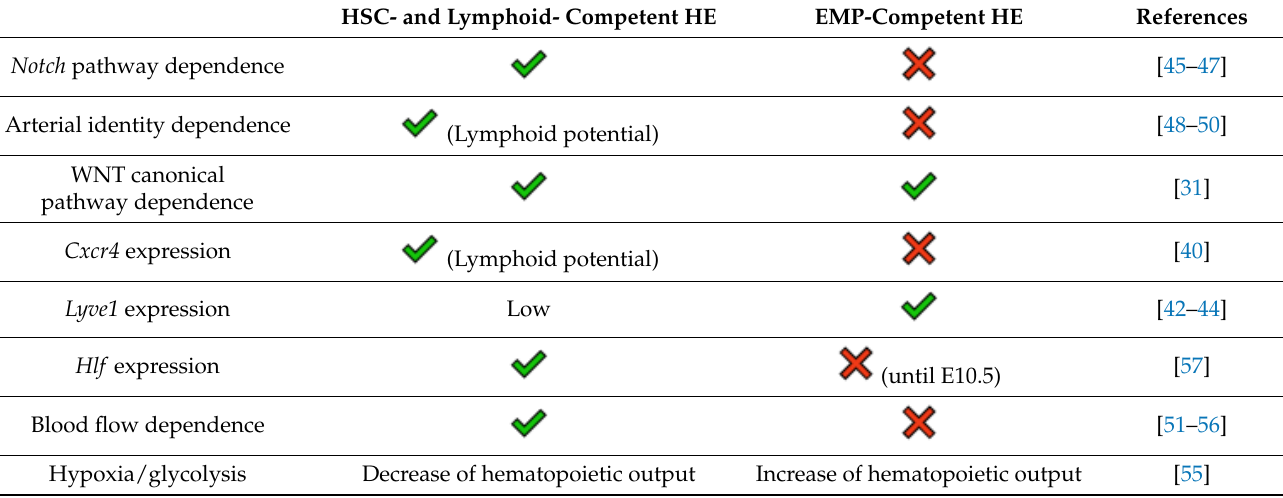
Table 1. Characteristics of EMP-competent and HSC or lymphoid- competent hemogenic endothe- lium. A green tick icon indicates dependence on a pathway or expression of a marker. A red cross indicates lack of dependence on a pathway or absence of expression of a